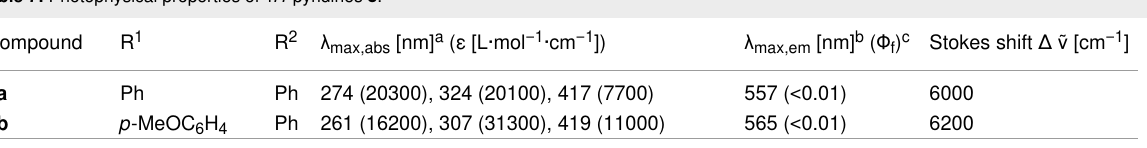
Table 7: Photophysical properties of 1 H -pyridines 8 .